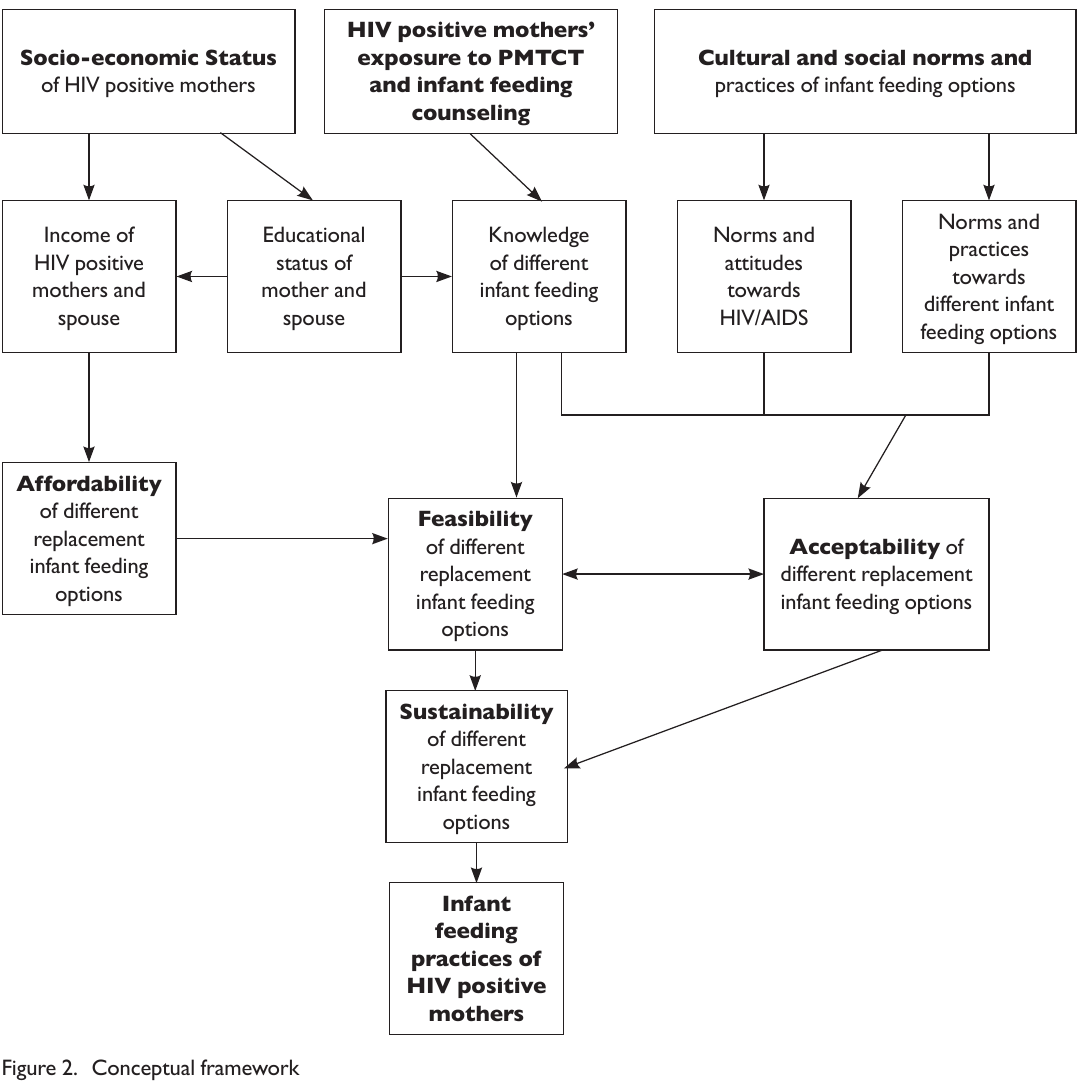
Figure 2. Conceptual